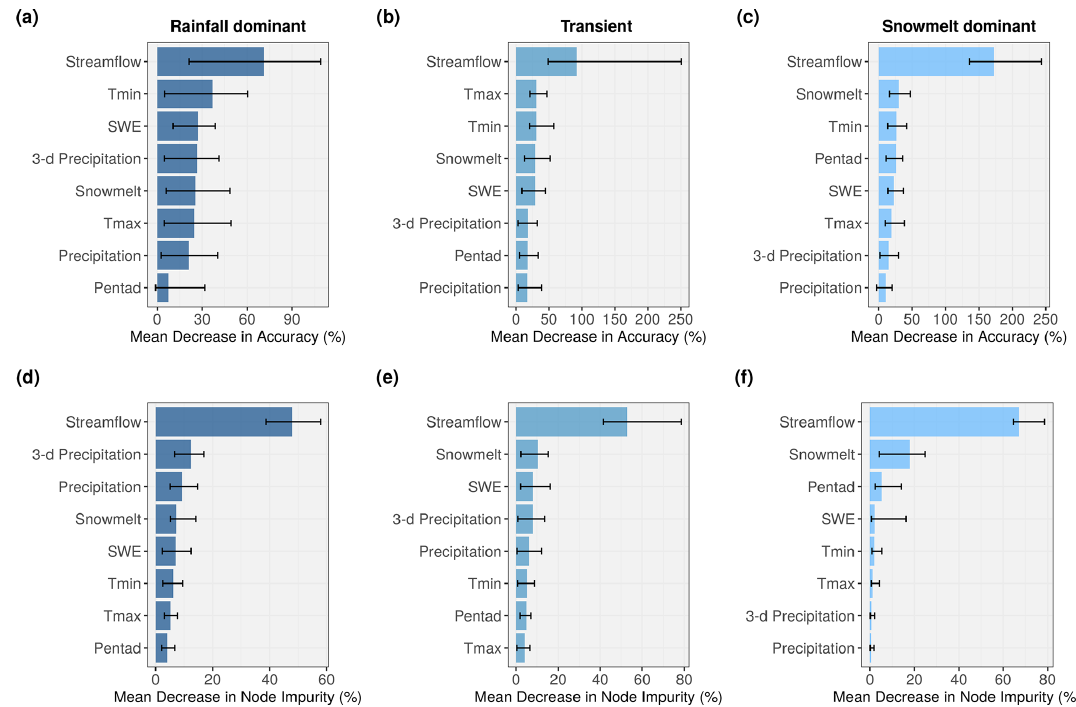
Figure 10. Bar plots showing the importance of predictor variables using (a–c) MDA and (d–f) MDI criteria. The length of the blue bars indicates the median value across the watersheds for each flow regime, and the thin black bar represents the full range of the